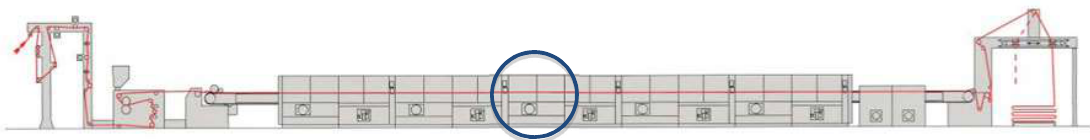
Figure 1. Stenter schematics with highlight of a single module [31].